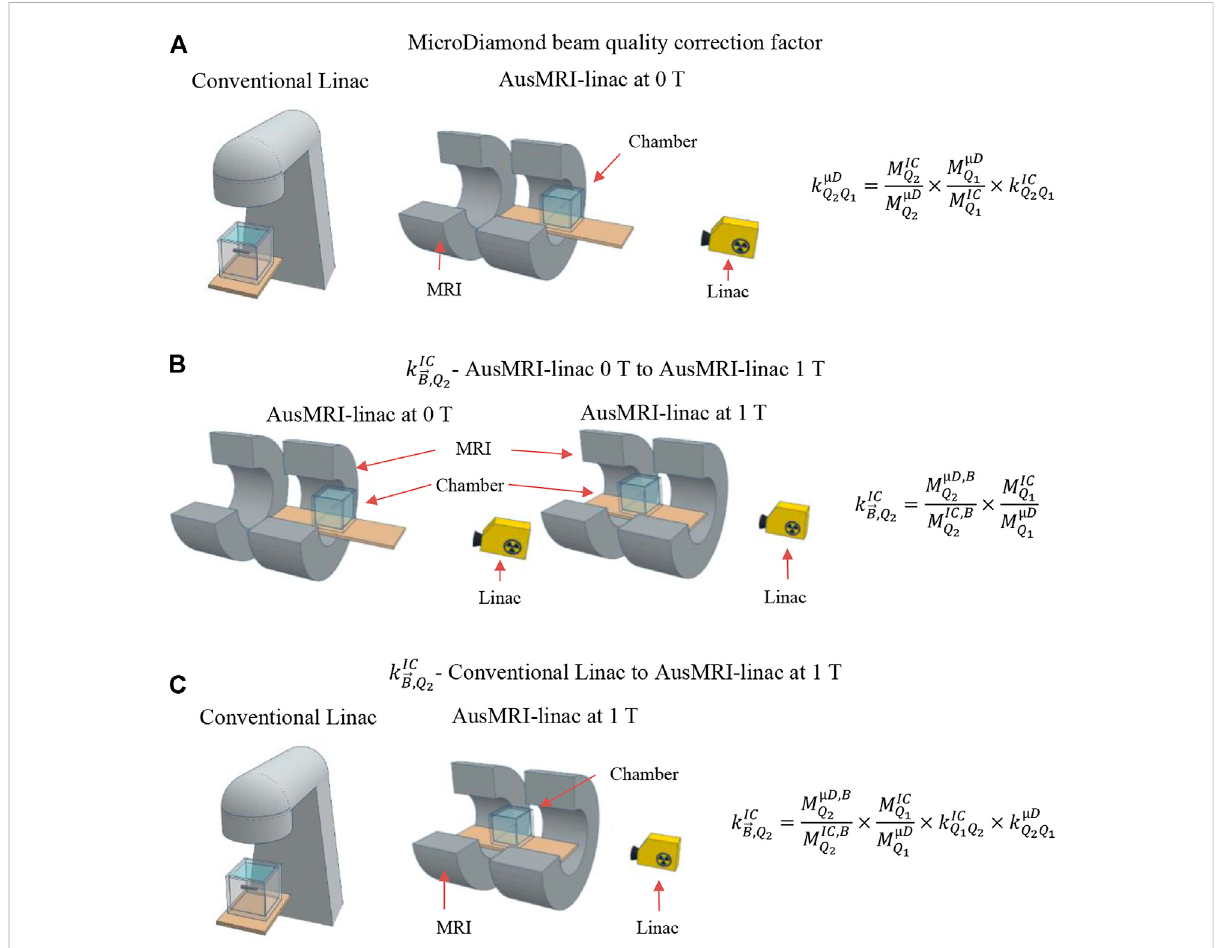
FIGURE 2 Schematic of the different measurements. (A) The microDiamond beam quality correction, k µD Q and the AusMRI-linac at 0 T. (B) The magnetic fi eld correction factor, k IC (cid:2) B , Q , was determined without corrections for beam quality via measurements on the AusMRI-linac at 0 T and AusMRI-linac at 1 T. (C) The magnetic fi eld correction factor, k IC (cid:2) B , Q , was measured with ion chamber and microDiamond beam quality correction factors from a conventional linac to the AusMRI-linac at 1 T. Similar measurements were used to determine the magnetic fi eld correction factor for an Elekta